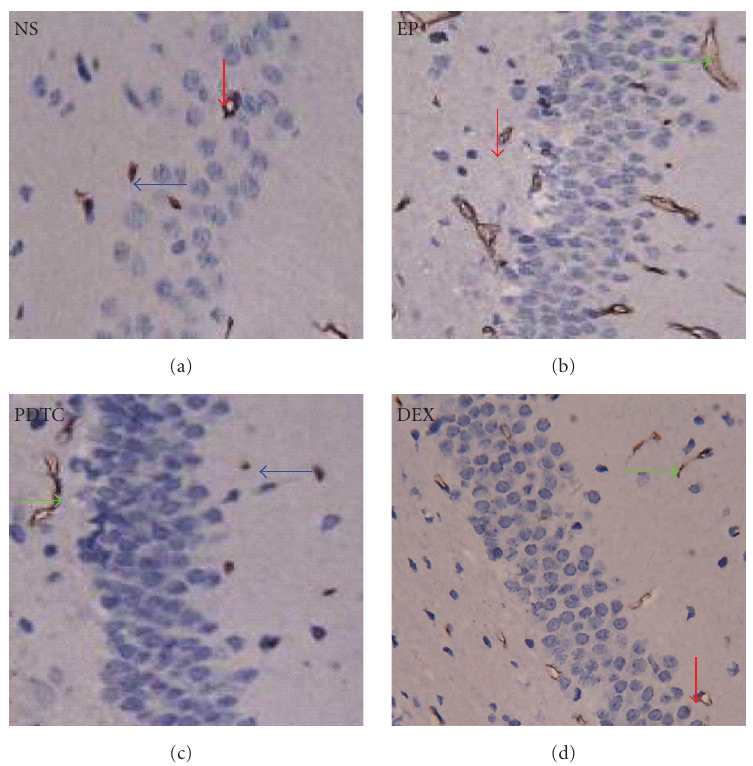
Figure 4: Pretreatment of PDTC and DEX both decreases KA induced P-gp overexpression. P-gp expression was detected by immunohistochemistry staining ( × 400) with an anti-P-gp antibody. A few P-gp positive cells were observed in the control NS group (NS). The number of the P-gp immunoreactive cells significantly increased in the KA micro-injected brain of EP group (EP), and it was mainly in vascular endothelial cells. By contrast with EP group, P-pg immunoreactive cells were decreased similarly in KA micro-injected brains pre-treated with PDTC (PDTC) or DEX (DEX). ↓ : Neurons; ← : glial cells; → : vascular endothelial